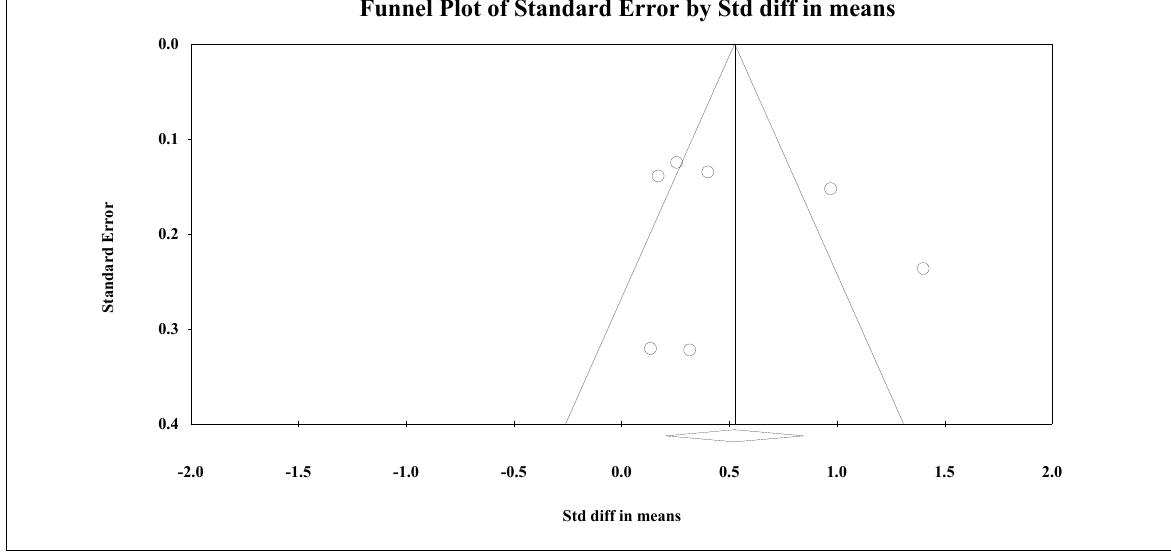
Figure 7. Publication bias in reporting of serum HbA1c levels outcome.